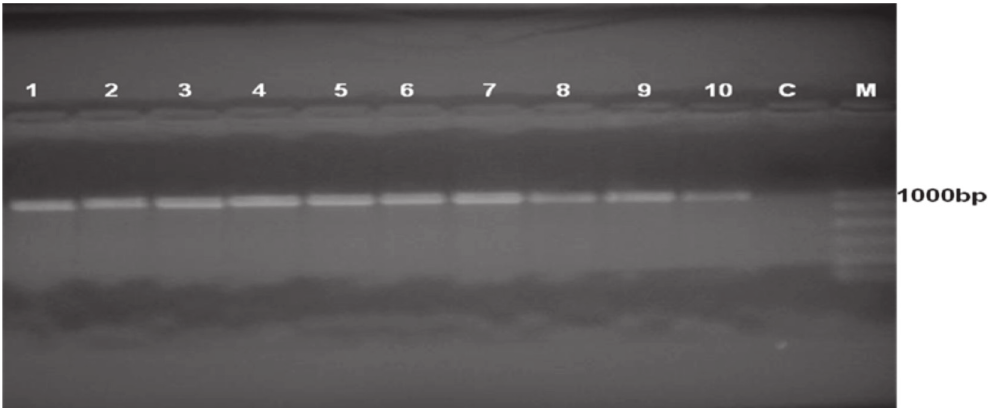
Figure 2. Agarose gel electrophoresis showing a band pattern (1 kb) of PCR ampli fi ed product with primers A and B. Lane 1 ‒ 10, EaMr82-09, EaMr83-09, EaMr84-09, EaMr85-09, LMG1877, LMG 2022, LMG 2024, LMG 2067, LMG 2074, and 40035; lane C, negative control; lane M, molecular